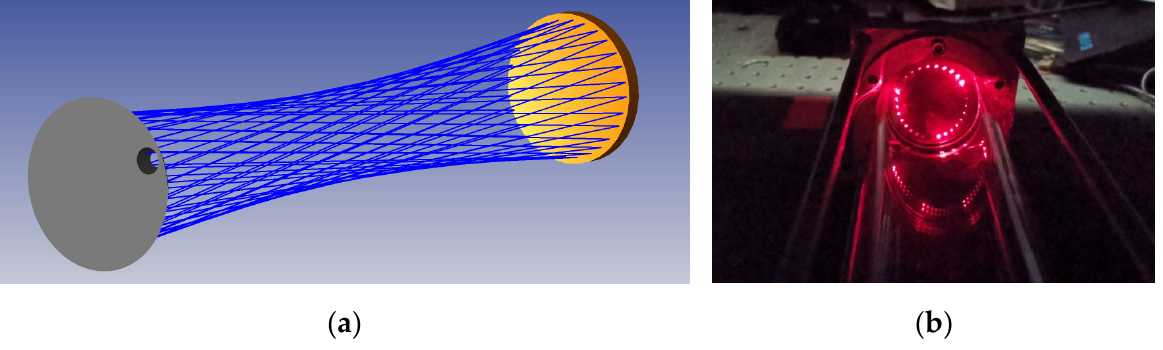
Figure 4. The designed Herriott gas cell. ( a ) The optical path model; ( b ) light spots in the mirror.